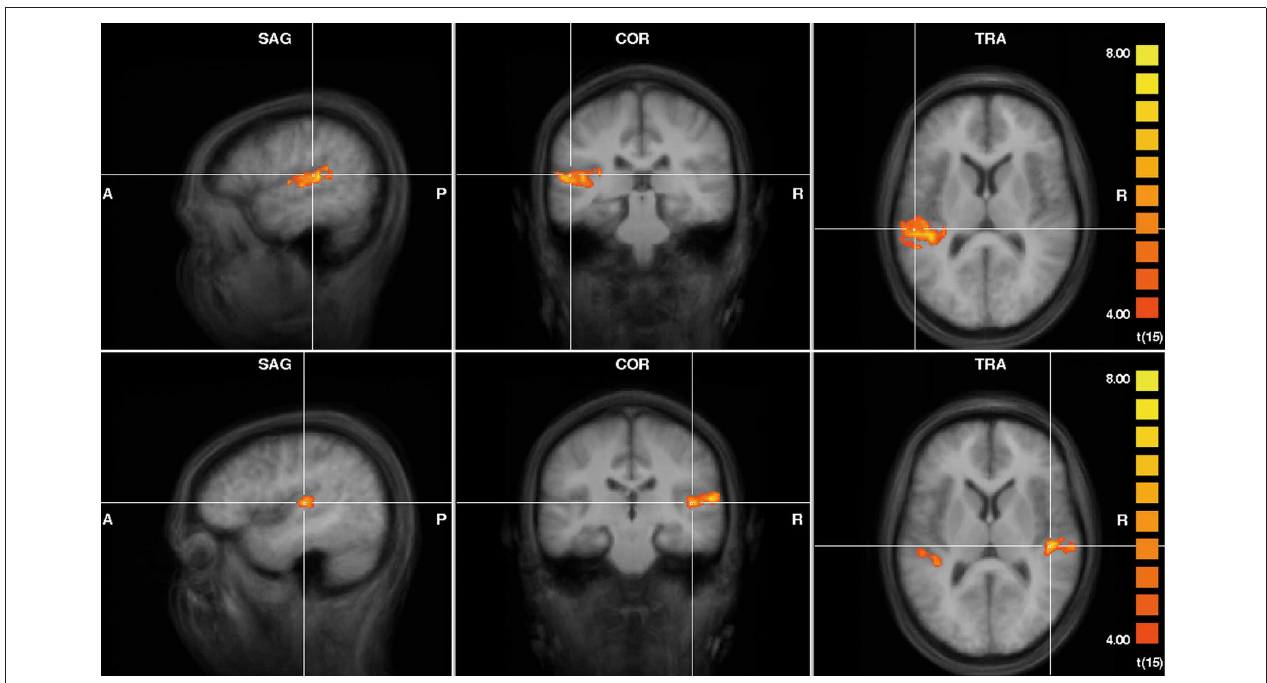
FIGURE 2 | Activity increase due to the additional presentation of contralateral noise during presentation of FM tones to the left ear (upper row; x = − 51, y = − 27, z = 12) and to the